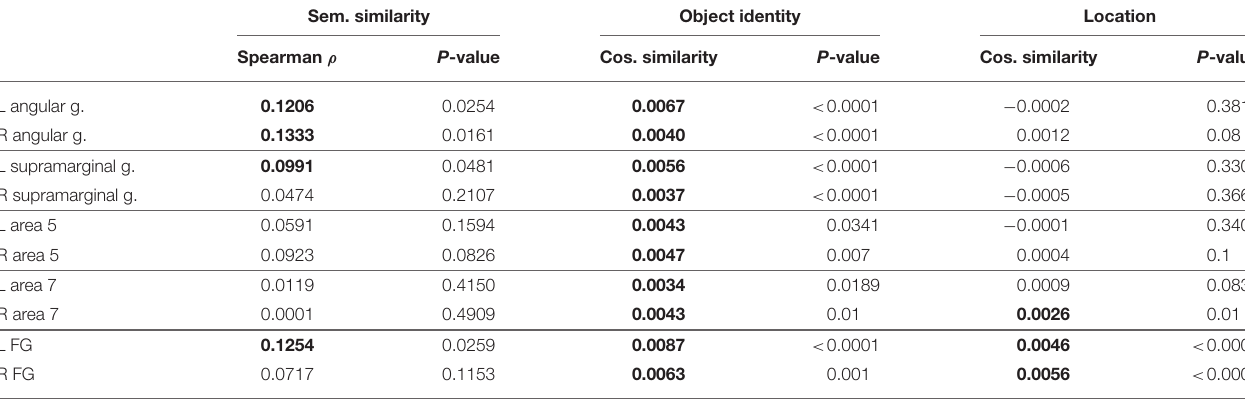
Column 2–3: Spearman correlations between the semantic similarity matrix and the fMRI similarity matrix. Columns 4–7: cosine similarity (CS) for location and object identity. Significant resultsatanuncorrectedP<0.05aremarkedinbold.SignificantresultsatanuncorrectedP<0.05aremarkedinbold.FG,fusiformgyrus,correspondingtothesumofcytoarchitectonic areas FG1, FG2, FG3, and FG4.